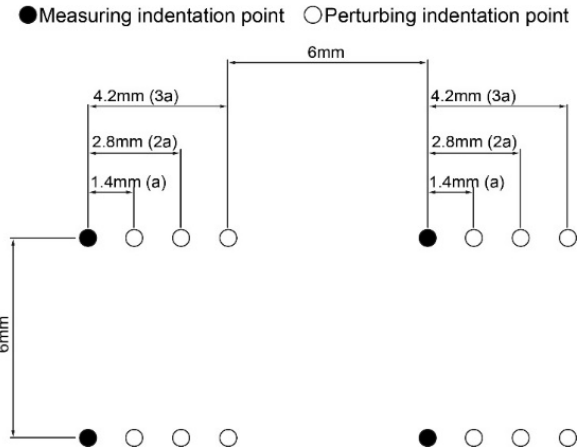
Figure 1. Scheme of the orthogonal grid used to evaluate the effect of perturbing indentations on the response of articular cartilage in the measuring indentation points.